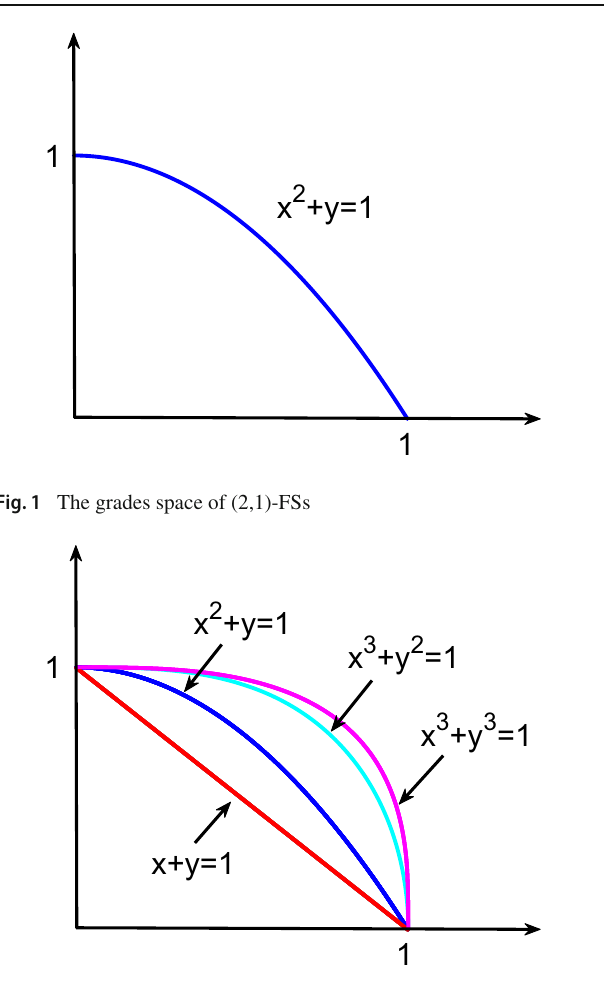
Fig.2 The relationships among the grades spaces of IFS, (2,1)-FS, PFS and FFS Example 4 Let Ω = ( 0 . 7 , 0 . 5 ) and Γ = ( 0 . 9 , 0 . 2 )